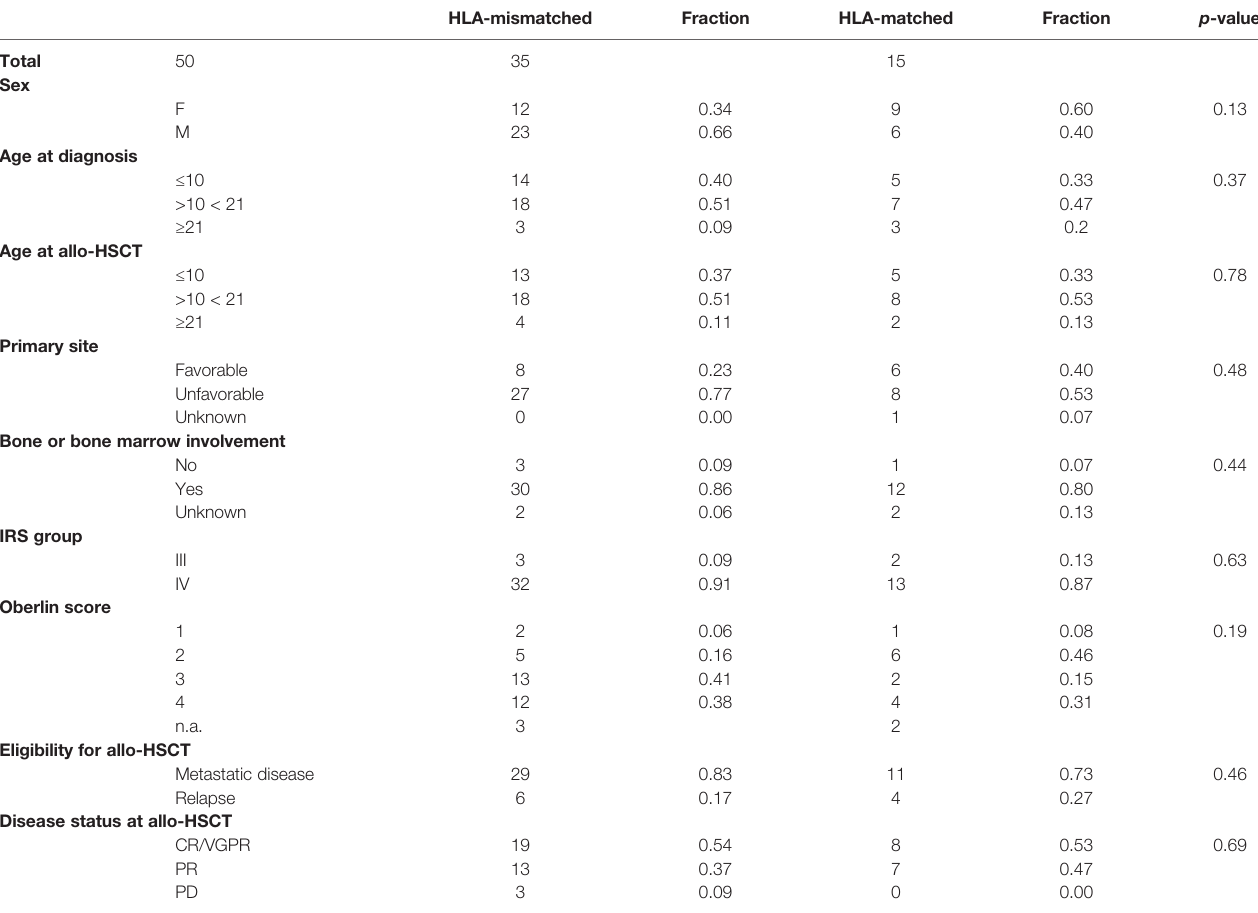
TABLE 1 | Patient